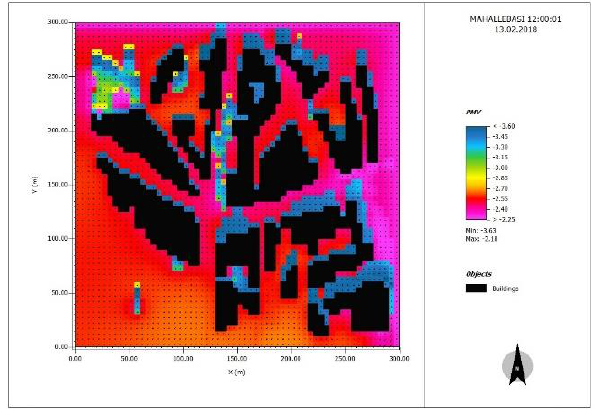
Figure 7. PMV Simulation for Mahallebasi